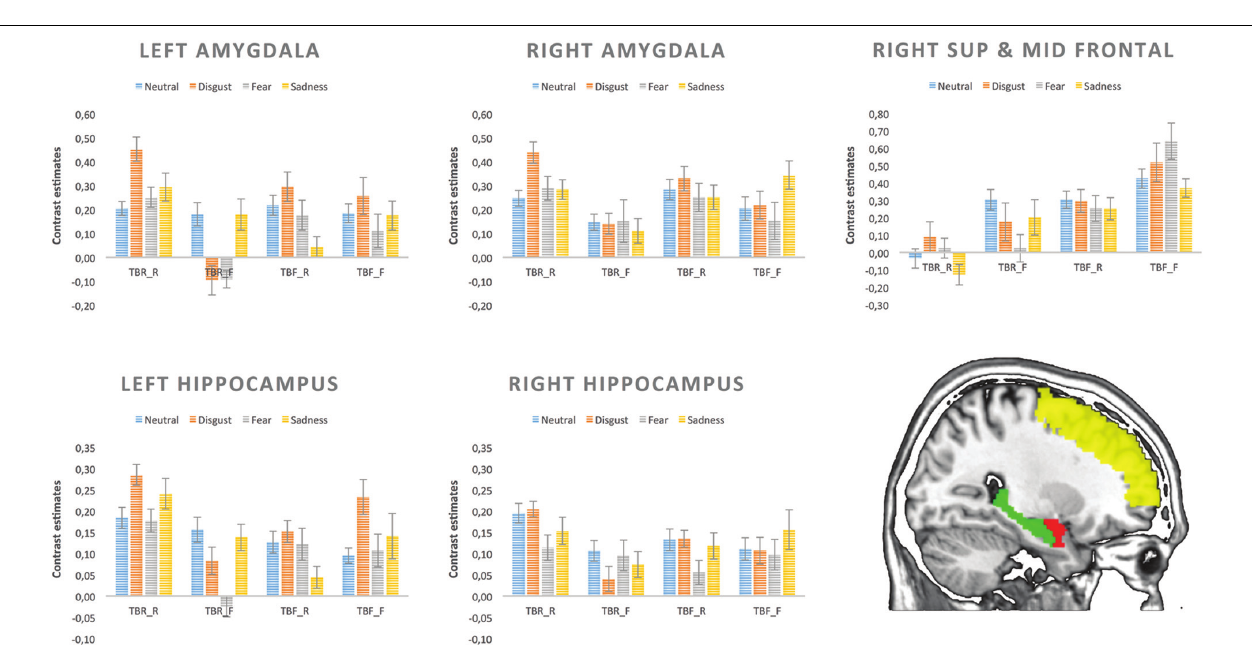
FIGURE 5 | The effect of intentional remembering and intentional forgetting in the whole brain analysis.